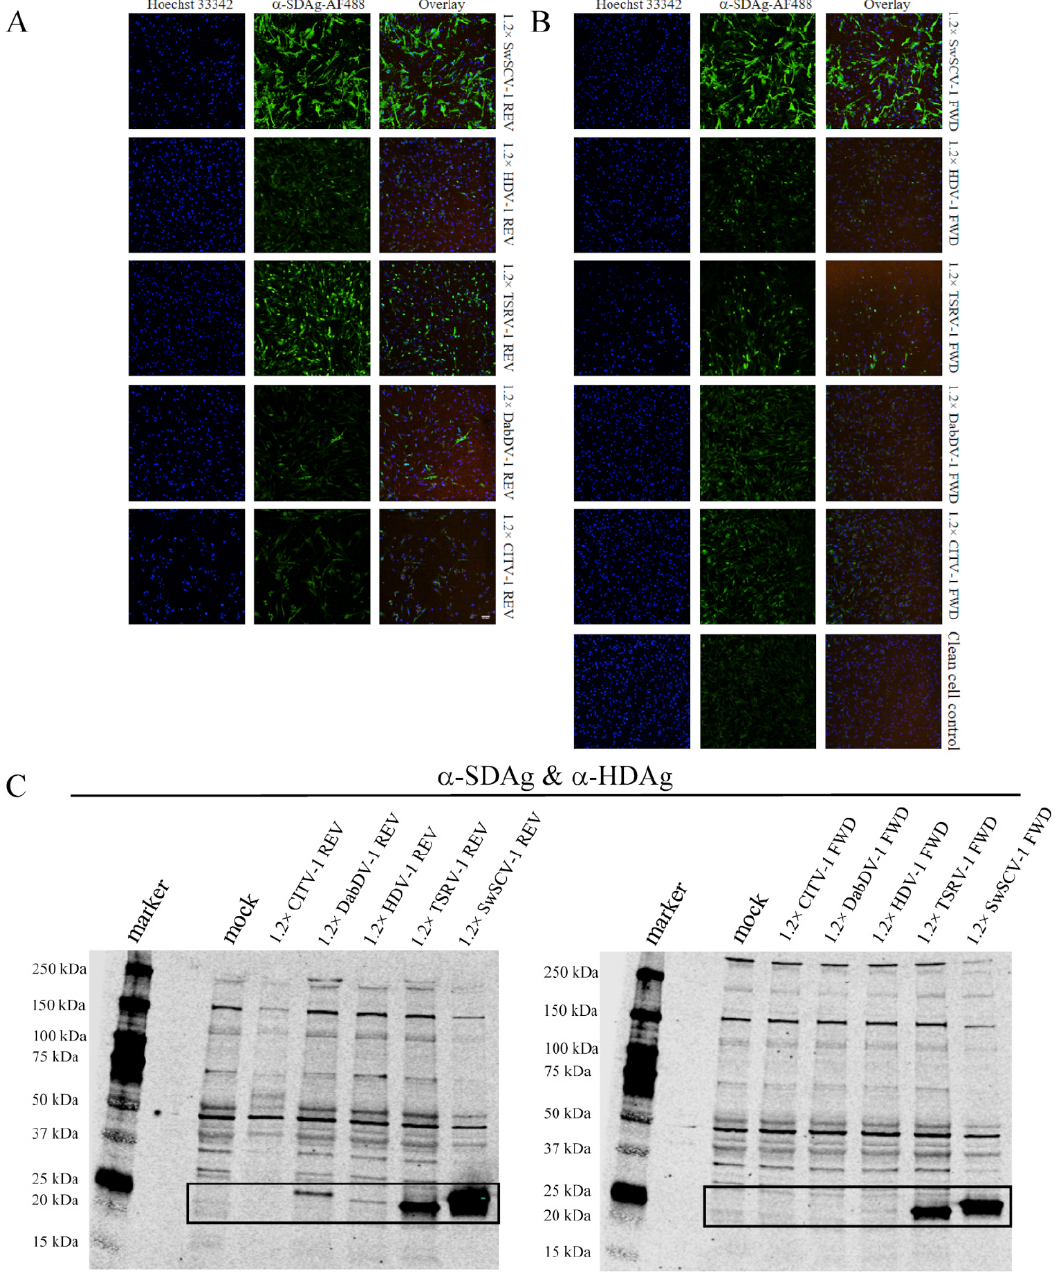
Figure 2. SwSCV-1 DAg antiserum cross-reactivity with the DAg of different kolmiovirids. ( A ) I/1Ki cells transfected with 1.2× SwSCV-1, HDV-1, TSRV-1, DabDV-1, and CITV-1 REV constructs were stained for the DAg at 4 days post transfection using rabbit α -SwSCV-1 DAg antiserum (1:100 dilution). ( B ) I/1Ki cells transfected with 1.2× SwSCV-1, HDV-1, TSRV-1, DabDV-1, and CITV-1 FWD constructs and clean cell control were stained for the DAg 4 days post transfection using rabbit α -SwSCV-1 DAg antiserum (1:100 dilution). Hoechst 33342 served for detection of the nuclei ( left panels ), and AlexaFluor 488-labeled donkey anti-rabbit IgG as the secondary antibody for DAg detection ( middle panels ). The ( right panels ) show overlay of the nuclear and DAg staining. The images were captured using Opera Phenix High Content Screening System (PerkinElmer, Waltham, MA, USA) with 20× objective. ( C ) I/1Ki cells transfected with 1.2× SwSCV-1, HDV-1, TSRV-1, DabDV-1, and CITV-1 REV constructs ( left panel ) and FWD constructs ( right panel ) were submitted for western blot at 4 days post transfection. The samples were separated on 4–20% Mini- PROTEAN TGX gels (Bio-Rad), transferred onto nitrocellulose, and the membranes were probed with rabbit α -SwSCV-1 DAg antiserum and affinity purified α -HDAg antibody. We loaded 1/3 volume of the 1.2× SwSCV-1 REV and FWD samples. The bands corresponding to the different DAgs are marked with the black rectangle. The results were recorded using Odyssey Infrared Imaging System (LI-COR Biosciences).